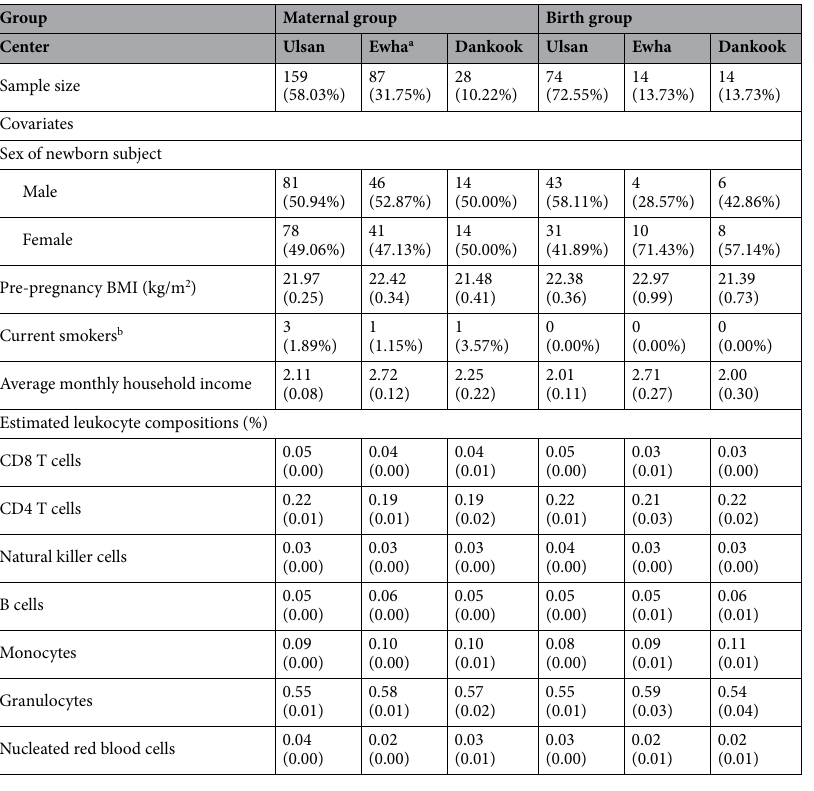
Table 1. Summary statistics for Ulsan, Ewha, and Dankook centers for maternal and birth group samples. Center-specific sample sizes for each group and their percentages are shown. For binary covariates, the respective count and percentage are shown. For continuous covariates, the average values are shown with standard errors in parentheses. a One maternal sample from the Ewha Center was not assessed for MnBP concentration; thus, the corresponding data were excluded from the analysis. The data shown are relative to 274 subjects, including one subject without MnBP concentration. b Smokers refer to the matched mothers for newborn subjects in the birth